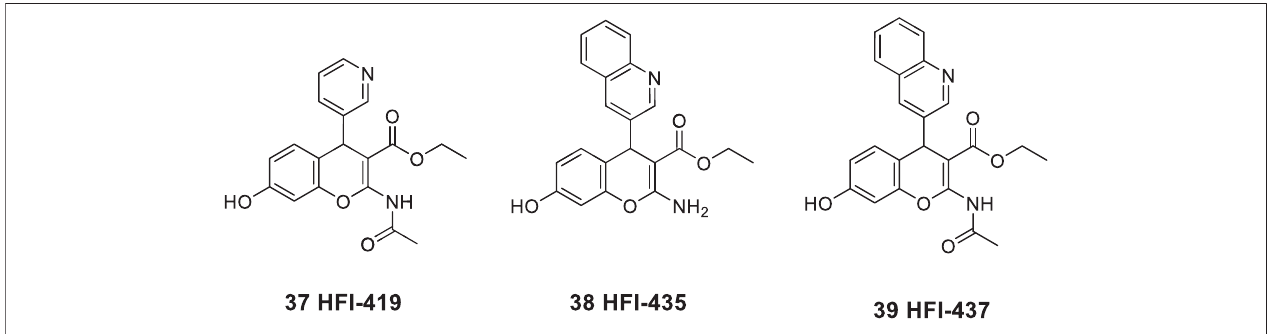
Figure 9 | The fi rst drug-like small molecule IRAP inhibitors reported. The benzopyran derivatives 37 , 38 , and 39 were discovered after in silico screening.